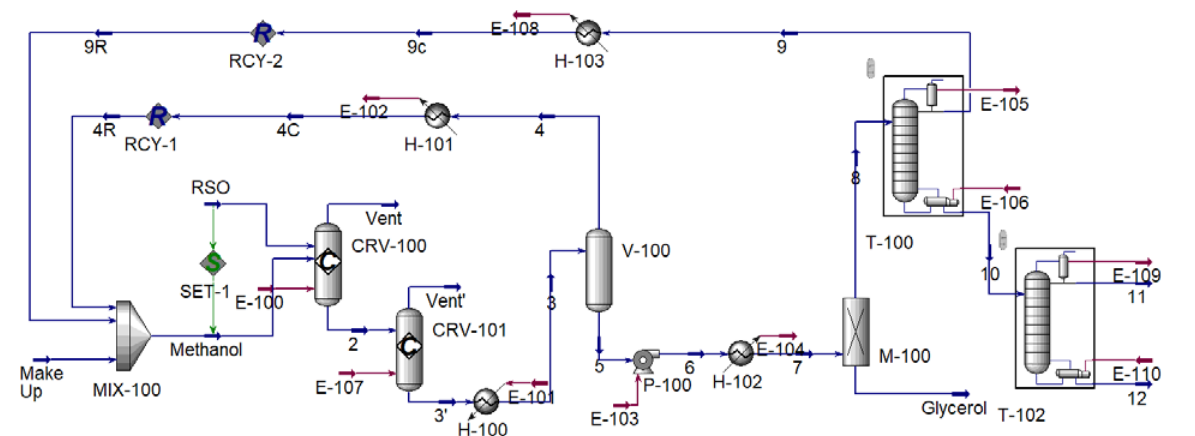
Figure 3. Simulation flowsheet using Aspen Hysys v11.